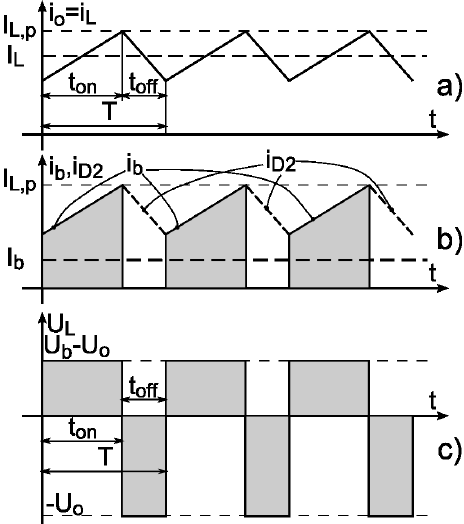
Figure 4. Layout 2 discharge operation: current and voltage waveforms (continuous conduction).